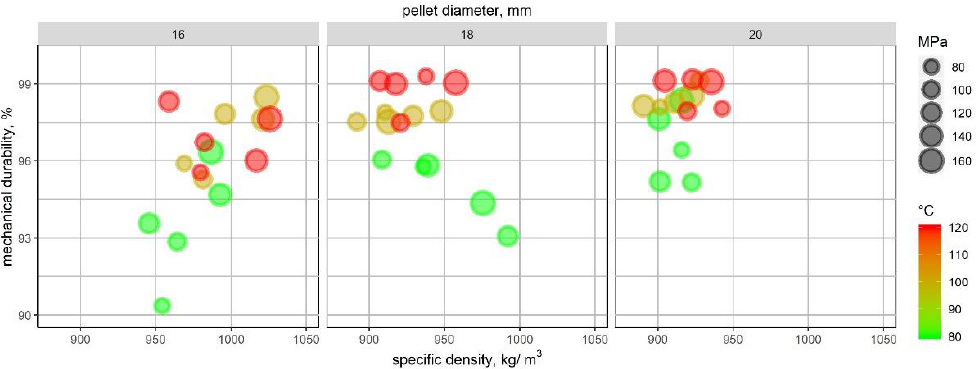
Figure 17. The relationship between mechanical durability and specific density. Average values for series (five granules). Size represents compaction pressure and colours are in connection to temperature.